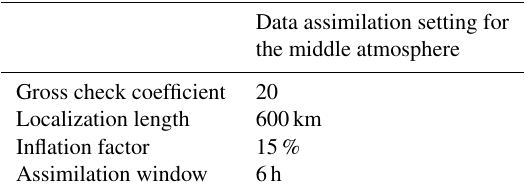
Table 1. Parameters obtained in Koshin et al. (2020) for the assim- ilation system of the whole neutral